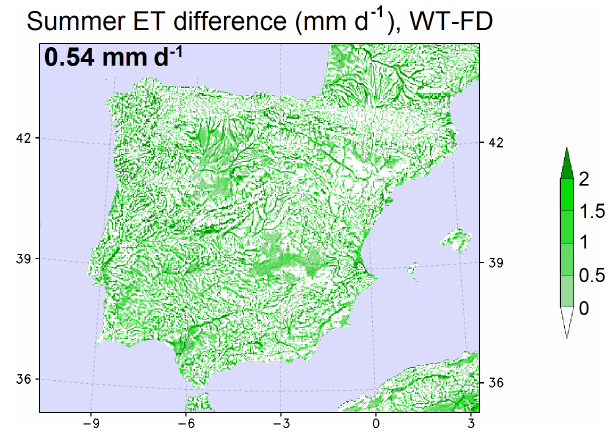
Figure 9. Mean summer (JJA) ET difference (mmd − 1 ) between the experiments with and without groundwater (WT − FD) for the 10- year simulation period and averaged value over the Iberian Penin- sula (black text in the top left